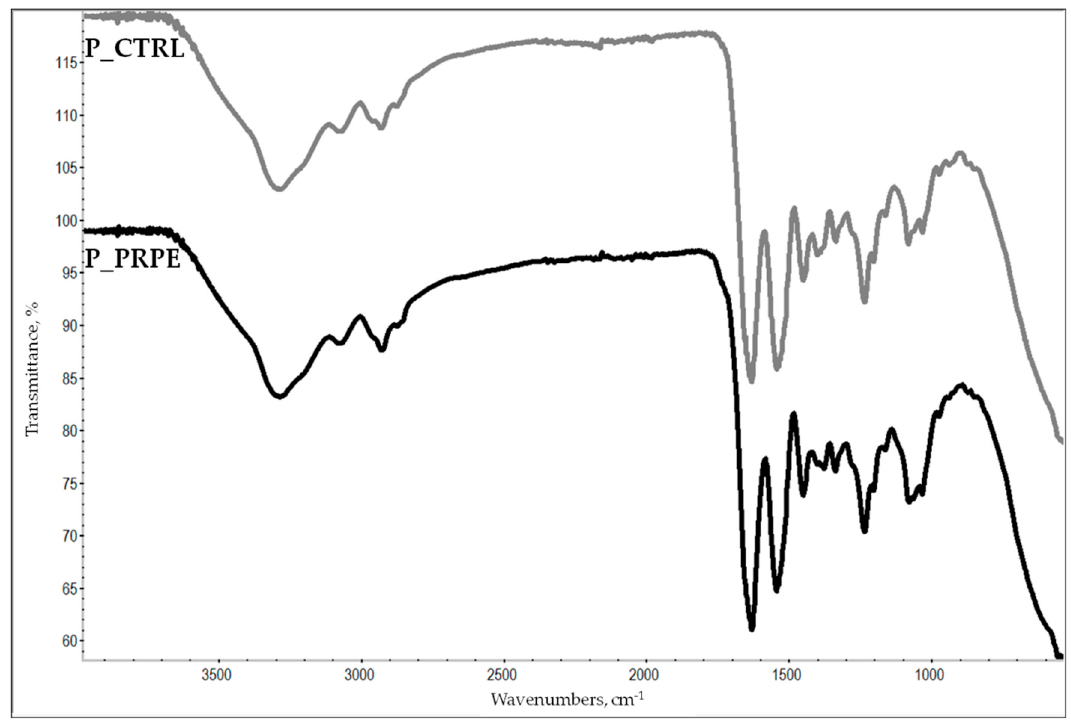
Figure 5. Attenuated total reflectance infrared spectroscopy (ATR-IR) of P_CTRL and P_PRPE between 4000 and 500 cm − 1 .